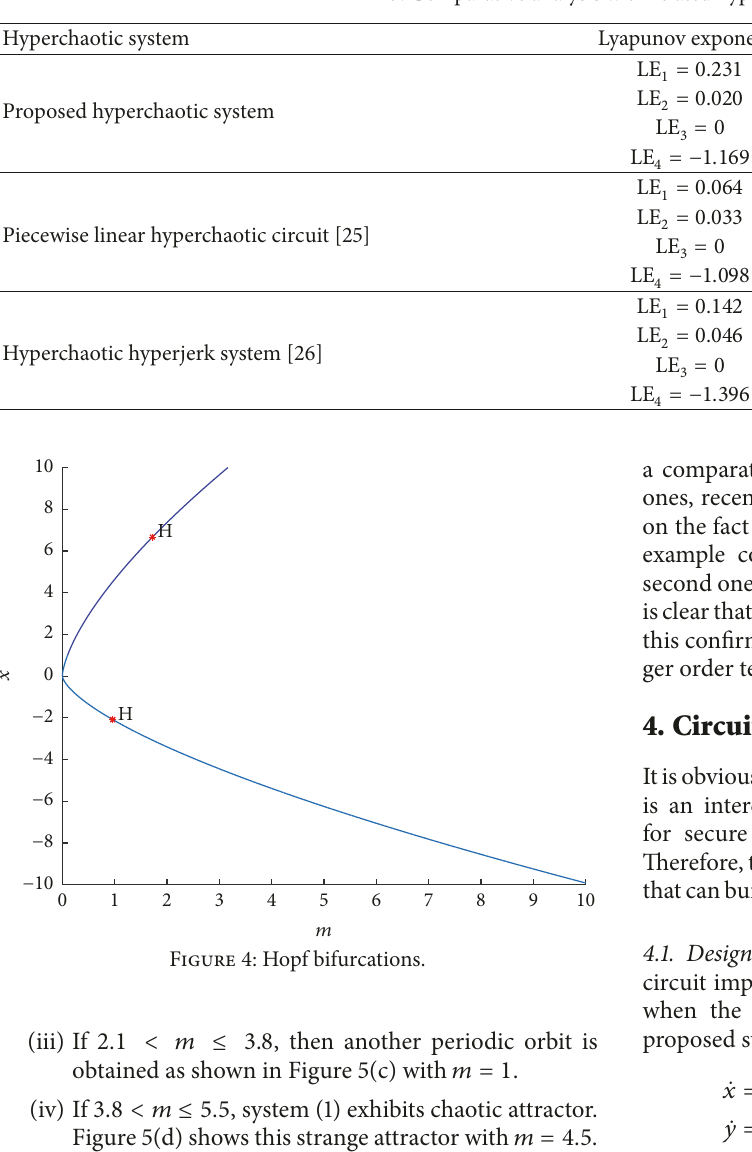
Table 3: Comparative analysis with related hyperchaotic systems.